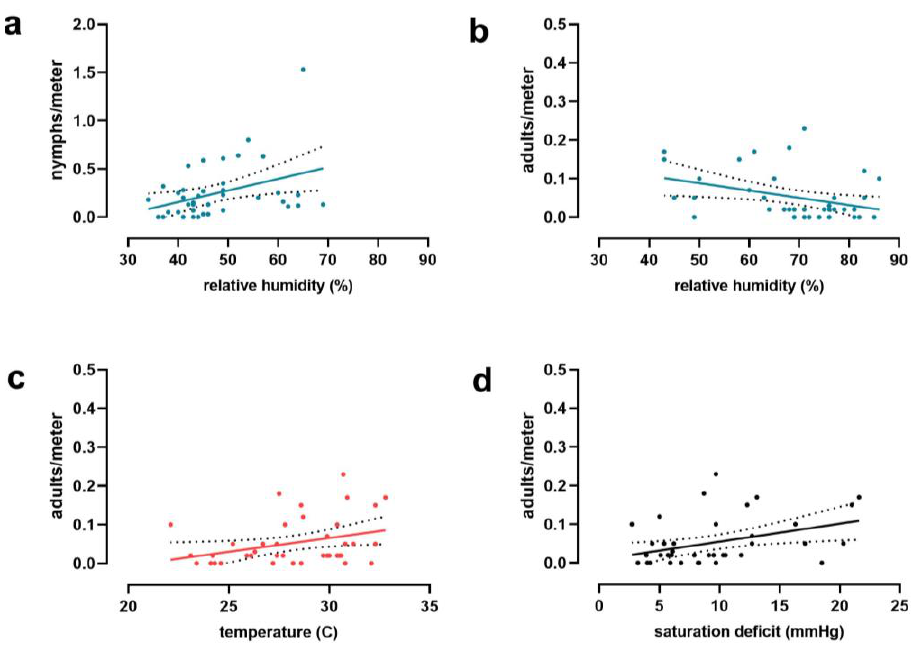
Figure 4. Representation of the linear regression equations between the environmental variables registered and the relative abundance of Haemaphysalis longicornis activity peaks of nymphs ( a ) and adults ( b – d ).